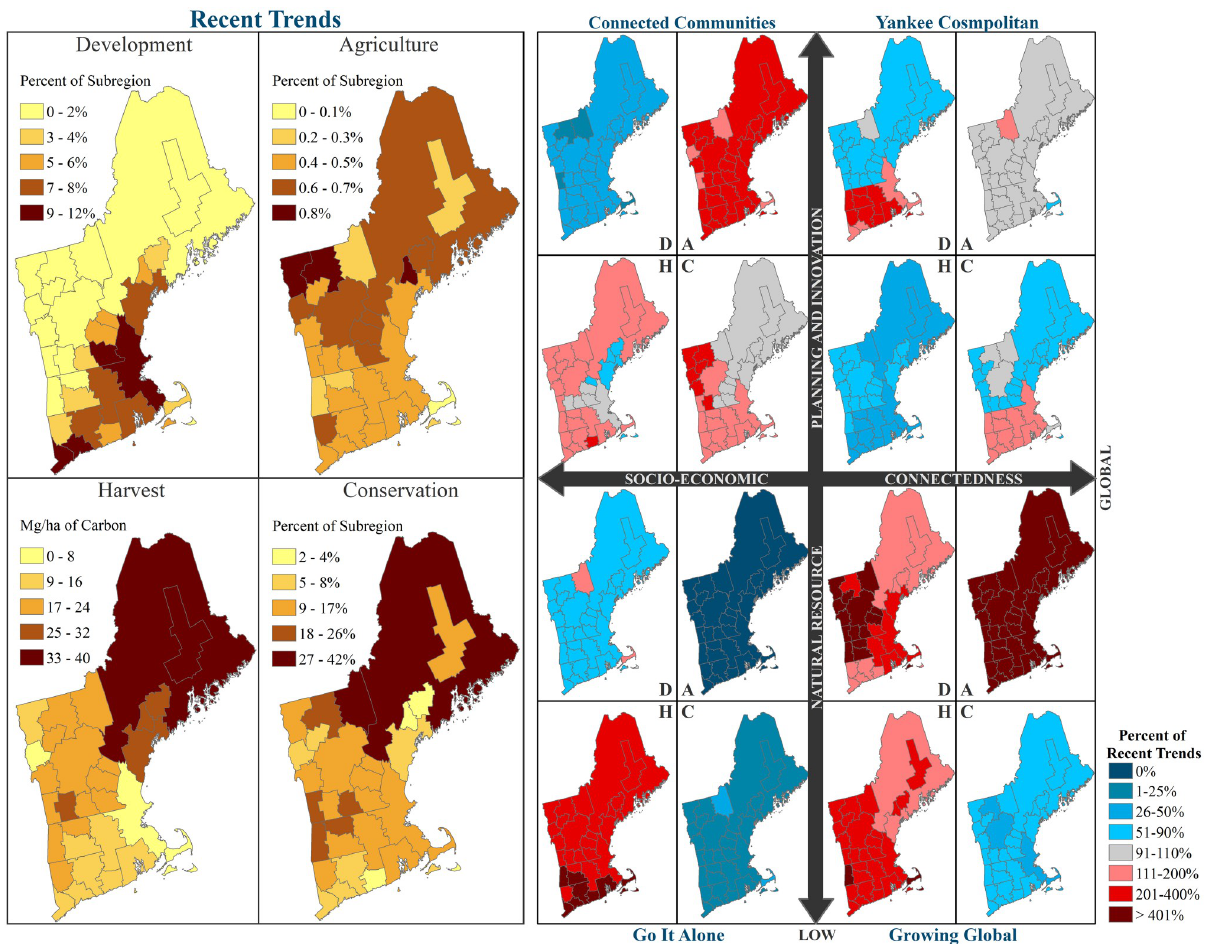
Fig 2. The NELFP scenarios used to estimate wildlife species future probability of occurrence throughout the New England region. Scenarios were built around two drivers of landscape change: 1) Natural Resource Planning & Innovation and 2) Socio-Economic Connectedness. The drivers form four alternatives scenarios to recent trends: “Connected Communities”, “Yankee Cosmopolitan”, “Go It Alone”, and “Growing Global”. Scenario- specific changes in development, agriculture, forest harvest, and conservation were simulated for the New England region over a fifty-year time period (2010 to 2060). Recent Trends scenario (left) displays the annual quantity of land cover and land use change broken down by subregion. The alternative NELFP scenarios (right) display the percent change from recent trends. Figure modified from a previously published figure in Thompson et al. [35]. Data sources: U.S. Census Bureau [29,36] and Plisinski et al. [30].